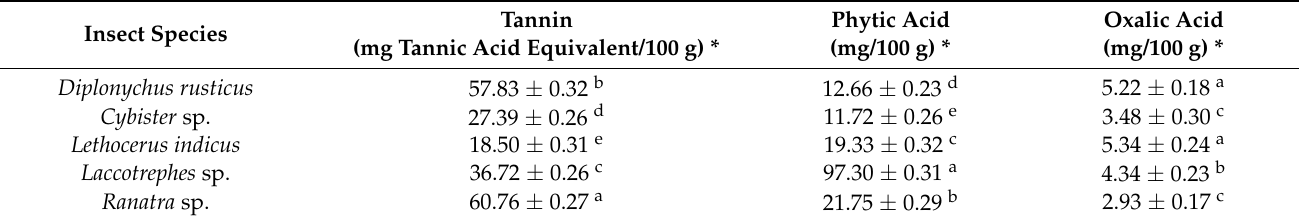
Table 5. Antinutritional properties of five aquatic insect species (d.w.) 1